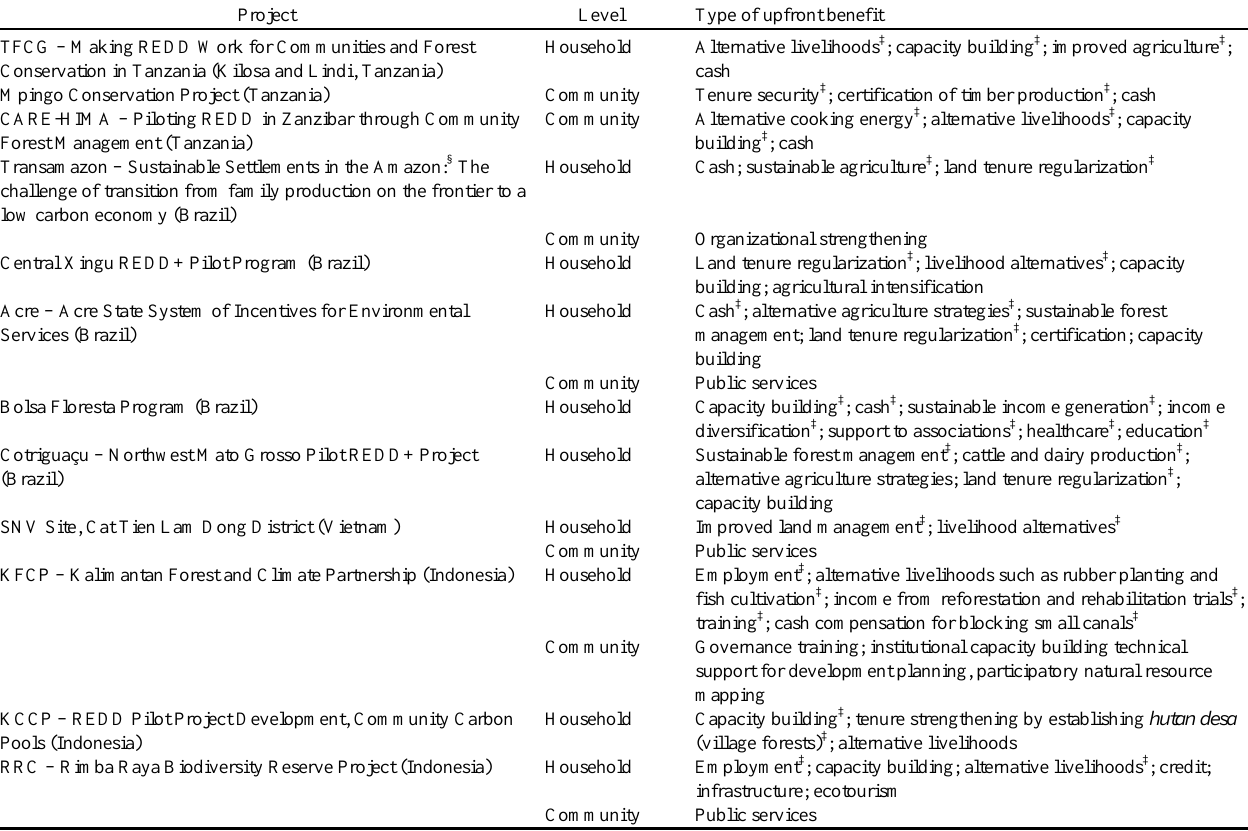
Table 1 . Types of benefits from 12 of the REDD+ projects studied and the level of the distribution. Projects were selected for this table to capture a range of the anticipated outcomes classified by projects as “benefits”† (adapted from Luttrell et al. 2012).